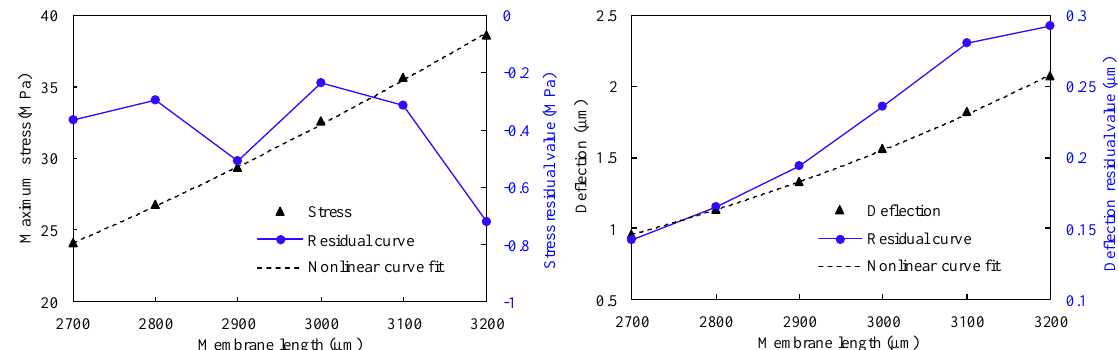
Figure 6. ( a ) Relationship between stress and membrane length; ( b ) relationship between deflection and membrane